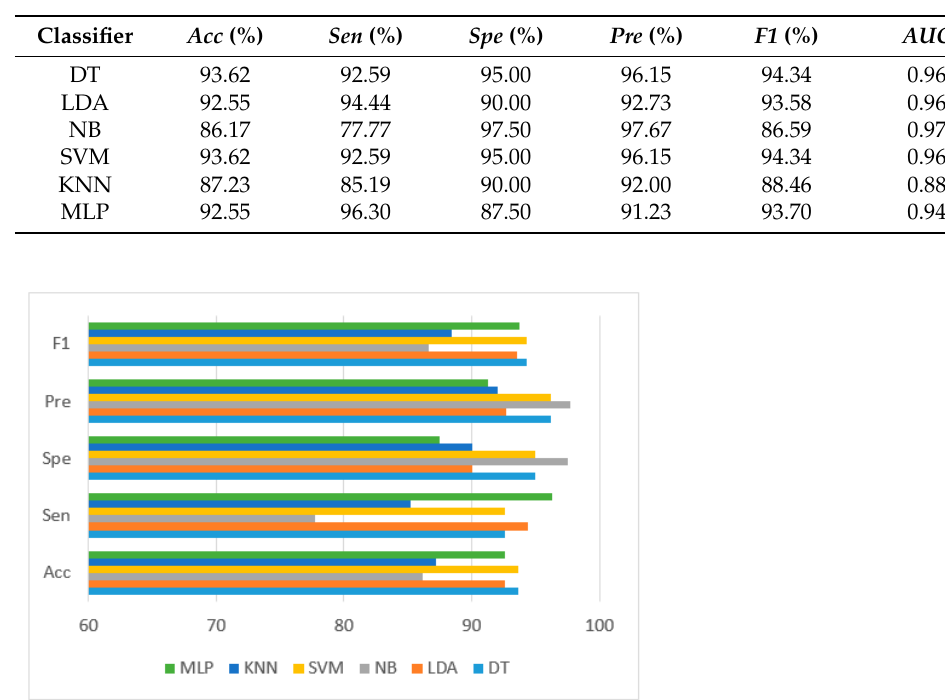
Table 3. Performance measures achieved by the classifiers trained and tested with morphologi- cal/GLSDM features.